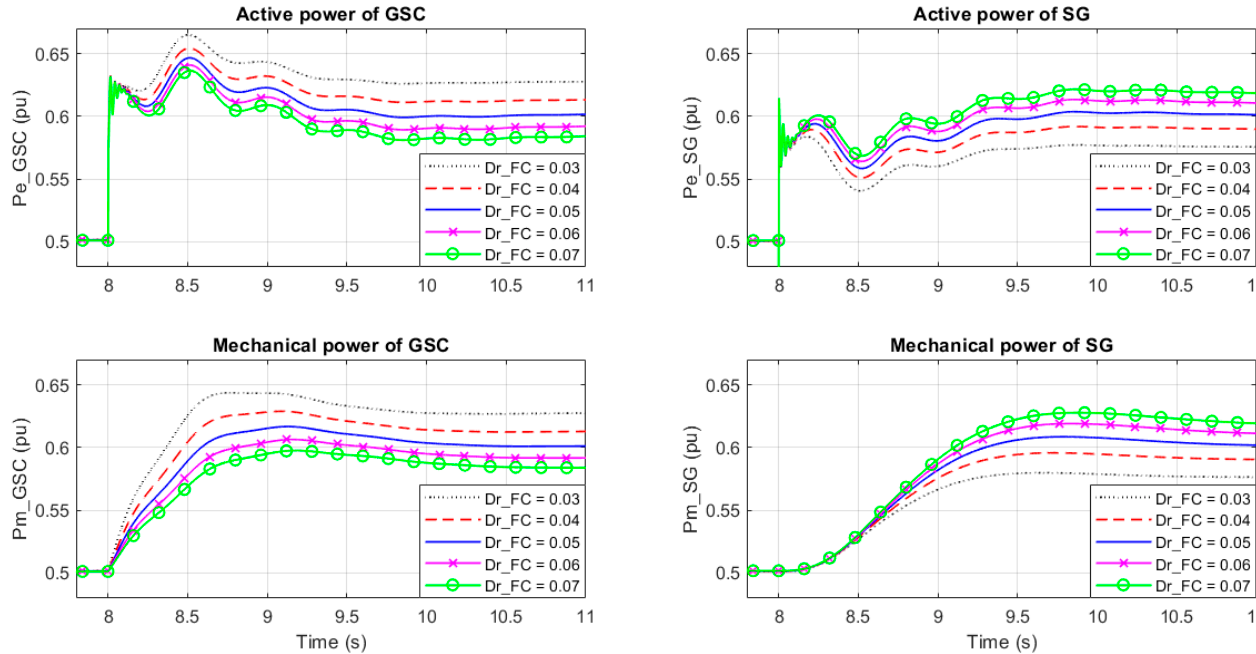
D on the virtual rotating speed of FC (H_FC = H_SG = 4 W·s/VA, r